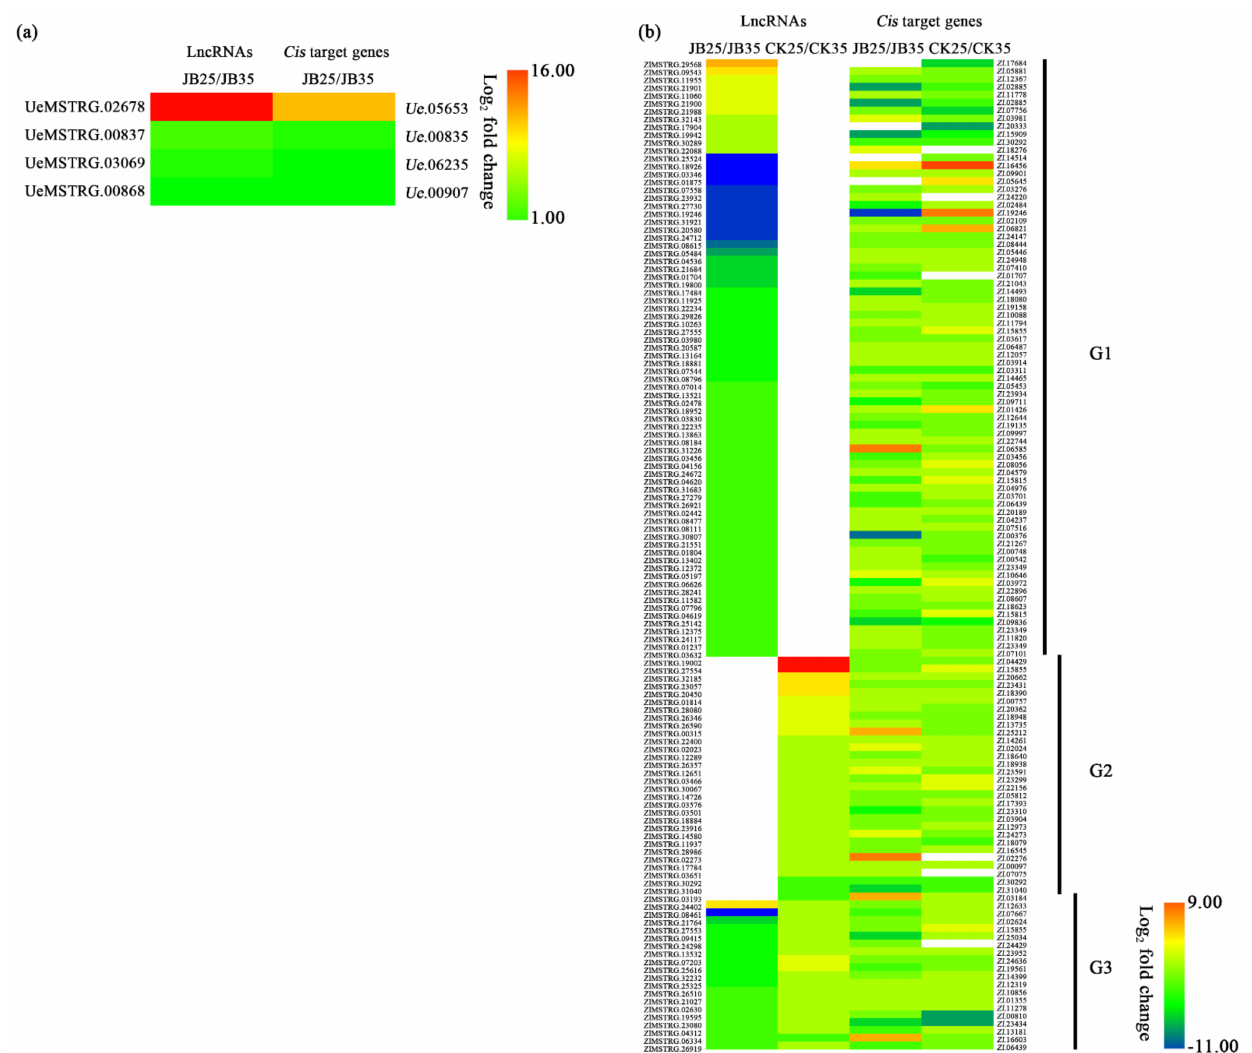
Figure 3. Heatmaps of differentially expressed lncRNAs and their cis -target genes in ( a ) Ustilago esculenta and ( b ) Zizania latifolia. JB25 and JB35 represent culms of Z. latifolia infected with U. esculenta grown at 25 ◦ C and 35 ◦ C, respectively. CK25 and CK35 represent culms of Z. latifolia without U. esculenta infection grown at 25 ◦ C and 35 ◦ C,